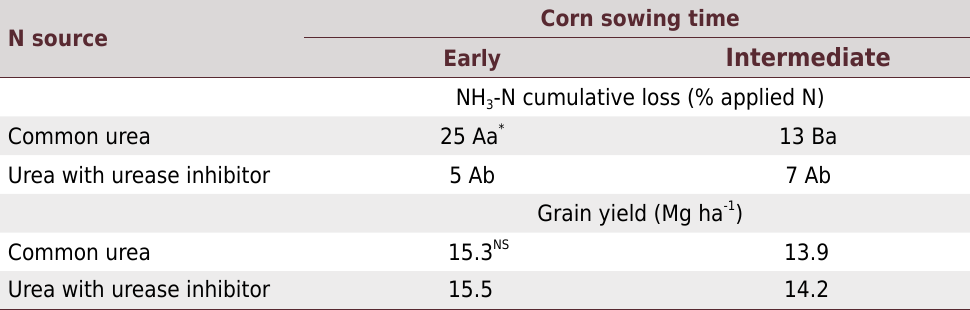
Table 2. The NH 3 -N cumulative losses by volatilization and corn grain yield as affected by N source and corn sowing time in Experiment I N